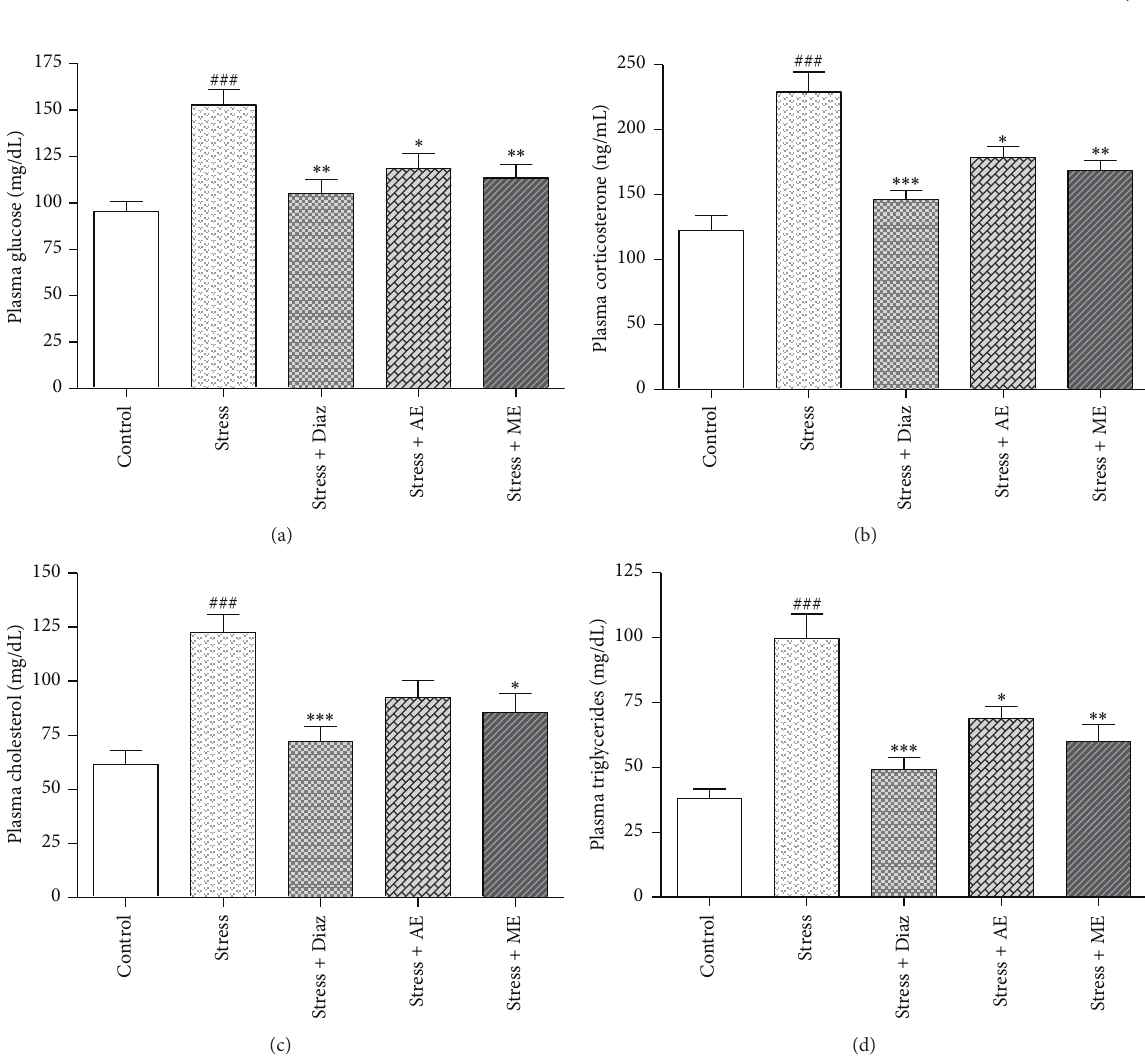
Figure 7: Effect of AE and ME seed extracts of Abelmoschus esculentus on acute restraint stress-induced changes in biochemical parameters. (a) Plasma glucose; (b) plasma corticosterone; (c) plasma cholesterol (d); plasma triglycerides. Mice were treated 7 days once daily with diazepam (2mg/kg, i.p.), AE, and ME (200 mg/kg, p.o.). The values shown are the mean ± S.E.M (𝑛 = 6) ; ### 𝑃 < 0.001 when compared to control group, ∗ 𝑃 < 0.05 , ∗∗ 𝑃 < 0.01 , and ∗∗∗ 𝑃 < 0.001 when compared to stress per se